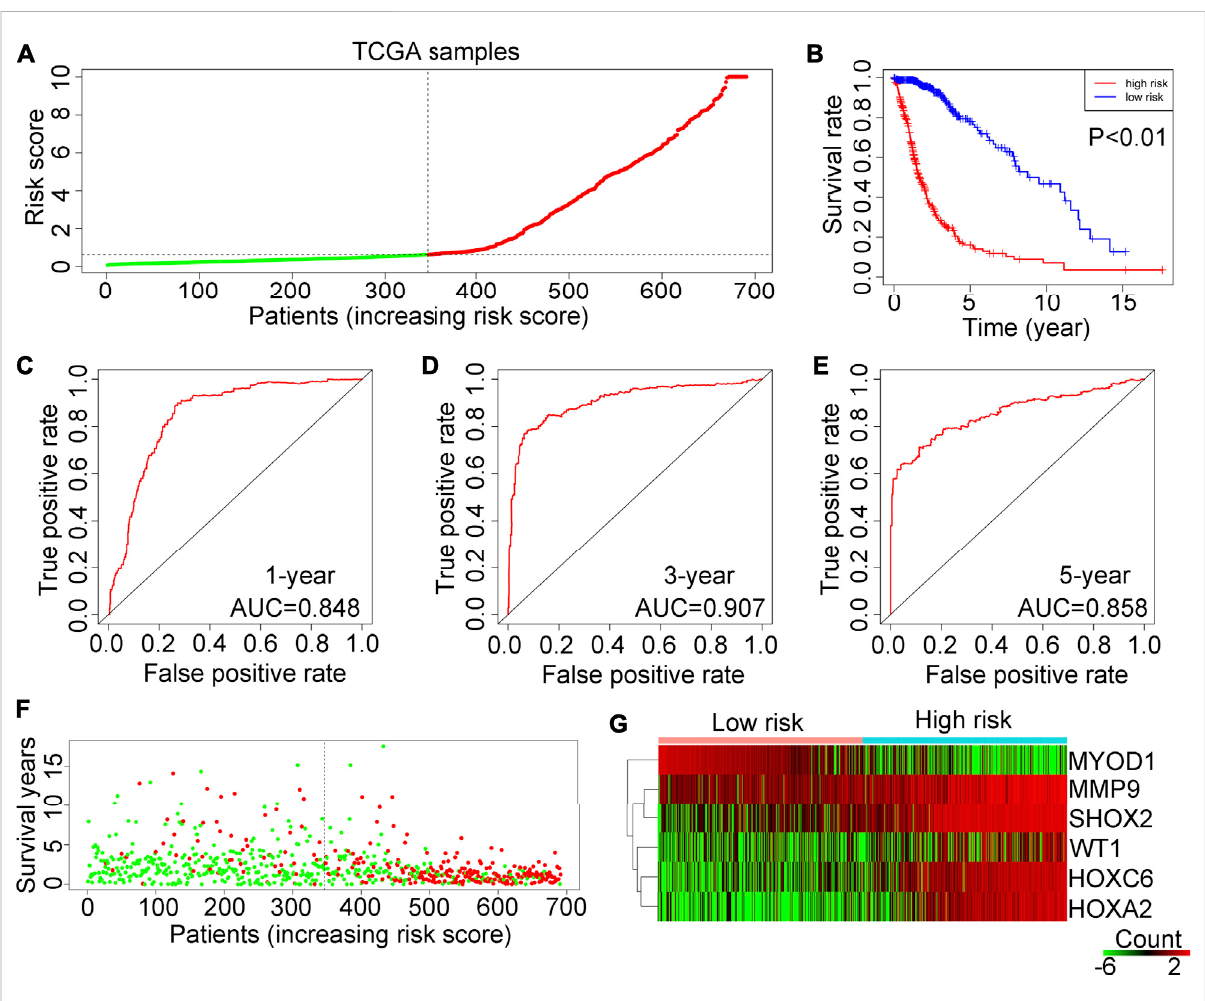
FIGURE 4 Examination of the risk model in the TCGA training cohort. (A) Gliomasamples in the TCGA were divided into low-risk and high-risk groups. (B) Kaplan – Meier plot analysis of the overall survival rates of low-risk or high-risk patients with glioma in the TCGA. (C – E) Receiver operating characteristic (ROC) curves showing the diagnostic value of the risk model for the 1-year, 3-year and 5-year survival rates of patients with gliomas in the TCGA. (F) Survival time and status of each glioma patient in the TCGA cohort. (G) Expression levels of MYOD1, MMP9, SHOX2, WT1, HOXC6 and HOXA2 in glioma tissues from patients with high-risk or low-risk scores in the